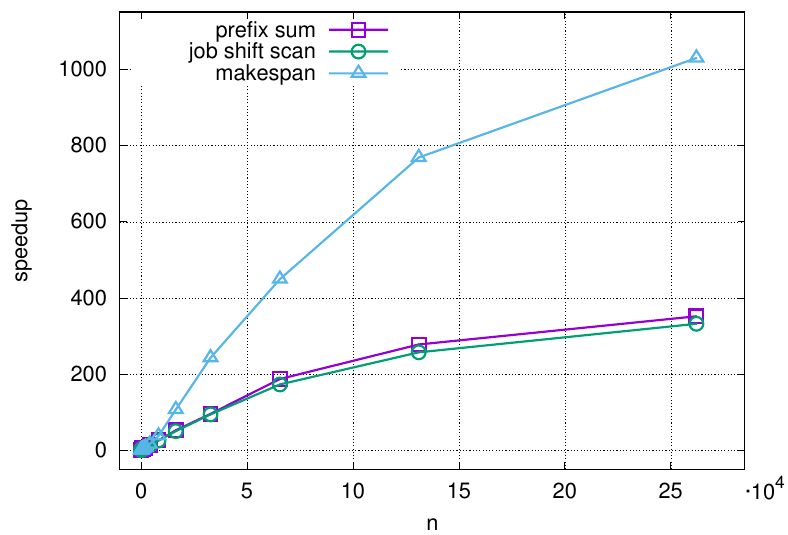
Figure 3. Measured GPU vs. GPU speedups as a function of the number of jobs for the prefix sum, job shift scan and